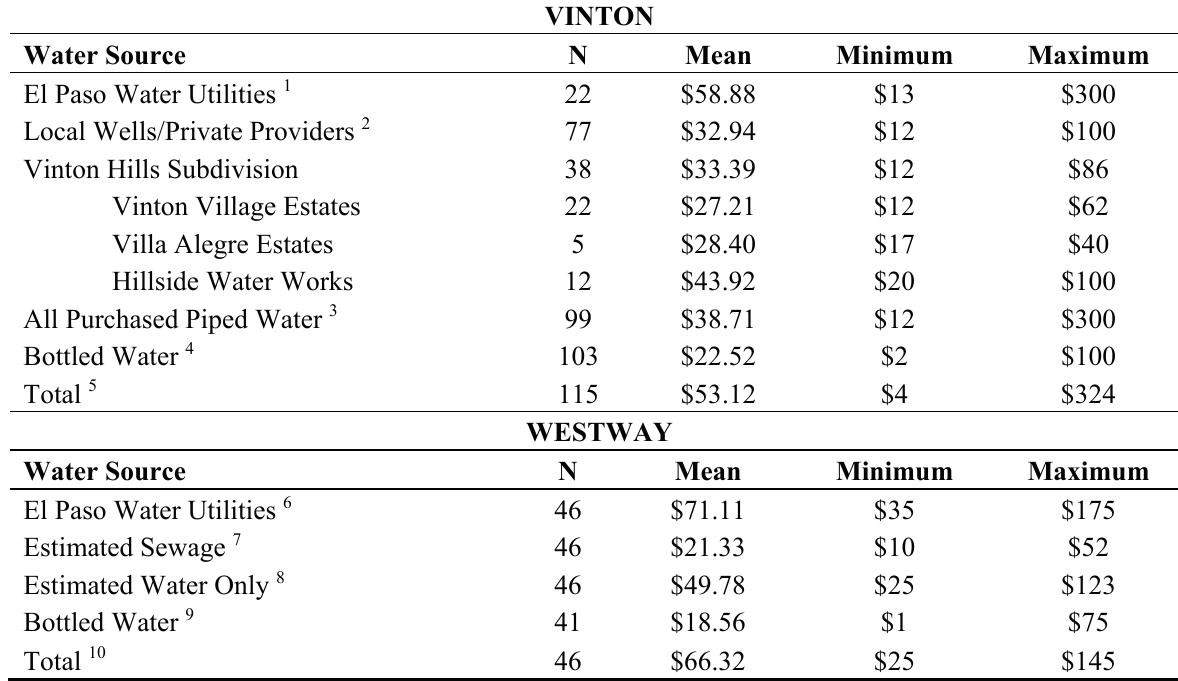
Table 4. Expenditures for water by individual households in Vinton and Westway (U.S. Dollars,